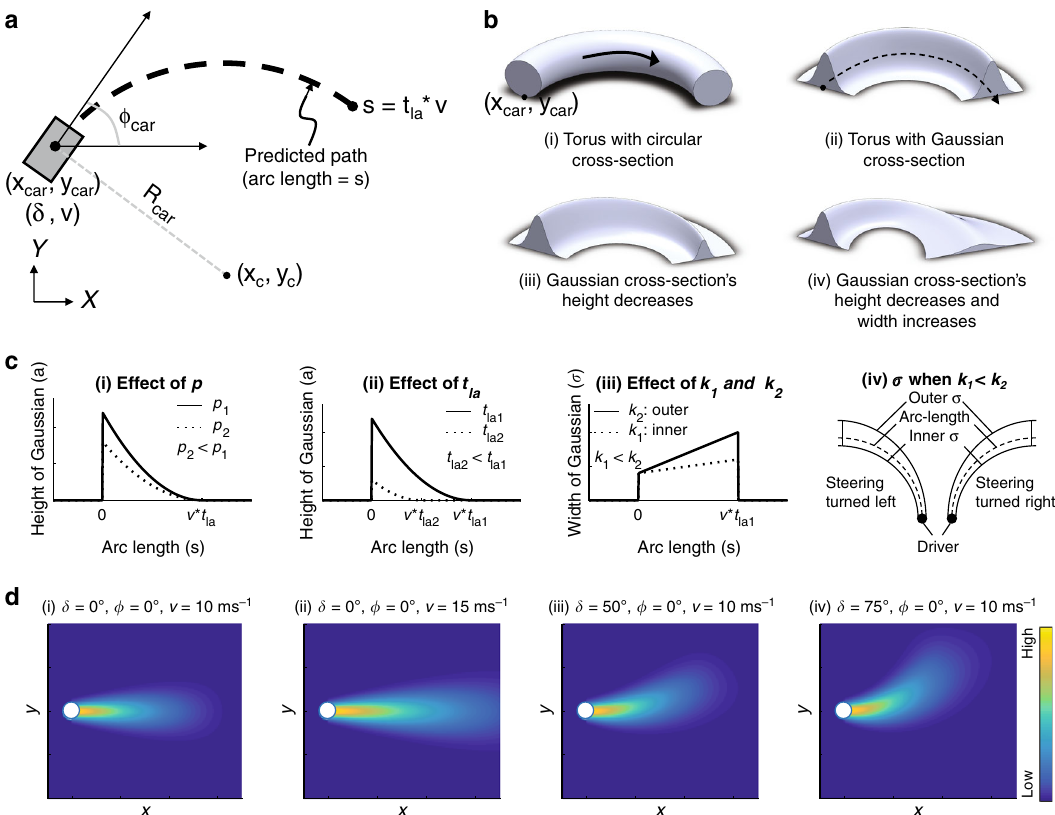
Fig. 2 Modelling the Driver ’ s Risk Field. a The ‘ predicted path ’ is calculated using the trajectory of vehicle kinematics, assuming constant steering angle ( δ ) and speed ( v ) for a fi xed look-ahead time ( t la ). b The DRF is modelled as a modi fi ed torus. Four steps are taken to form the DRF from (i) A torus that curves along the ‘ predicted path ’ . (ii) Cross-section of torus is modi fi ed to a Gaussian. (iii) Height ( a ) and (iv) width ( σ ) of the Gaussian become functions of arc length ( s ), Eqs. (3) and (4), respectively. c The DRF is parameterized by six parameters: p , t la , k 1 , k 2 , m , c . The effect of p (steepness of the parabola) and t la are shown in (i) and (ii) and emerge from Eq. (3). The maximum height of the Gaussian is determined by p , t la and speed. (iv) Parameters k 1 and k 2 link the steering angle to the width of the Gaussian. The DRF widens (if k 1 , k 2 > 0) or narrows (if k 1 , k 2 < 0). (v) k 1 and k 2 correspond to the inner and outer Gaussian widths, respectively. So, if k 1 < k 2 , the inner Gaussian is narrower than the outer, which enables ‘ corner cutting ’ in curves. d The fi gure shows the shape and magnitude of DRF as a function of the position in the driving scene (global x and y coordinates). The DRF is a dynamic fi eld that expands with an increase in speed (compare (i) – (ii)) and steering angle (compare (i) – (iii) and (iii) – (iv)). MATLAB code for DRF GUI is provided in the Code availability